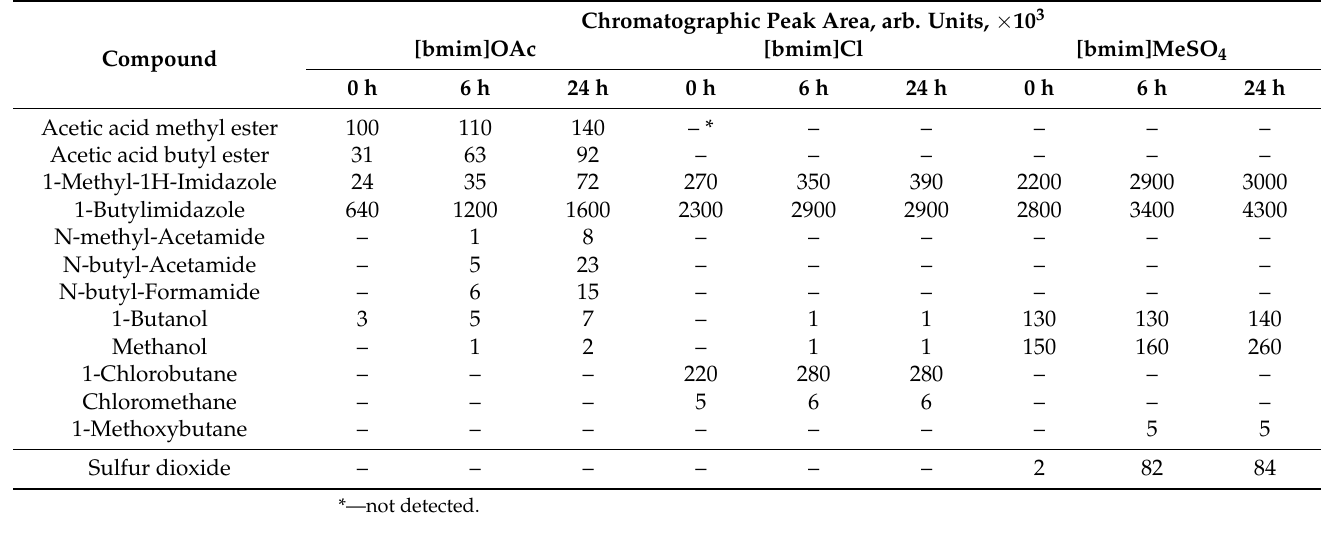
Table 2. Products of bmim acetate, chloride, and methyl sulfate pyrolysis at 242, 290, and 363 ◦ C, respectively, identified by Py-GC-MS before (0-h) and after 6- and 24-h thermal treatment at 150 ◦ C.